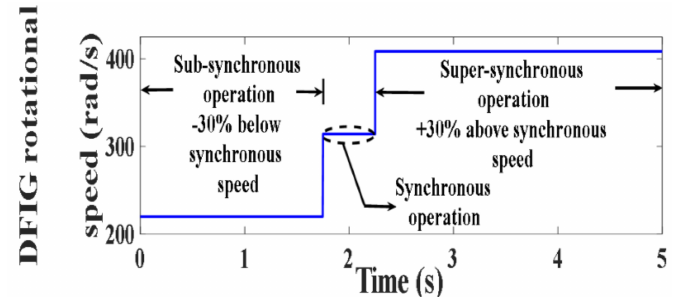
Figure 23. Prime mover operating speeds (rad/s).